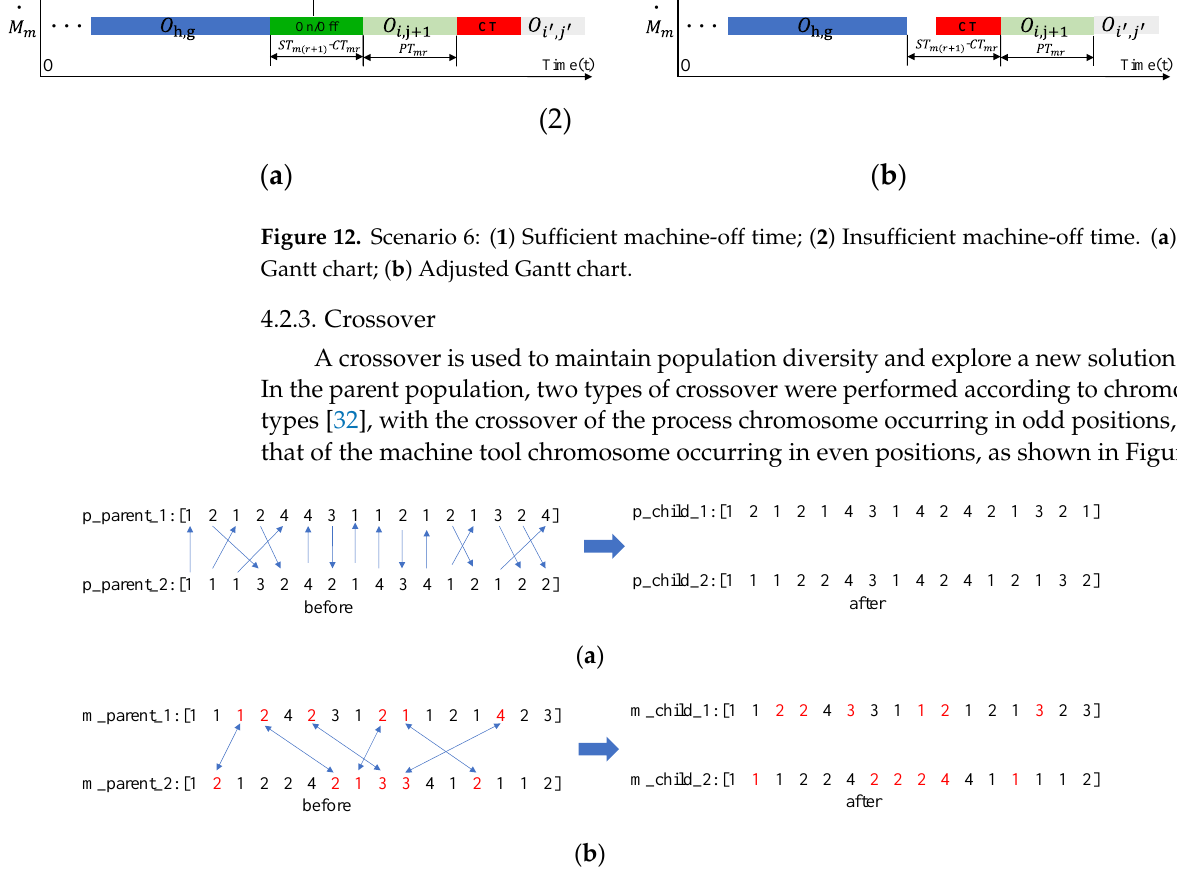
Figure 13. Crossover: ( a ) Crossover of the process chromosome; ( b ) Crossover of the machine tool